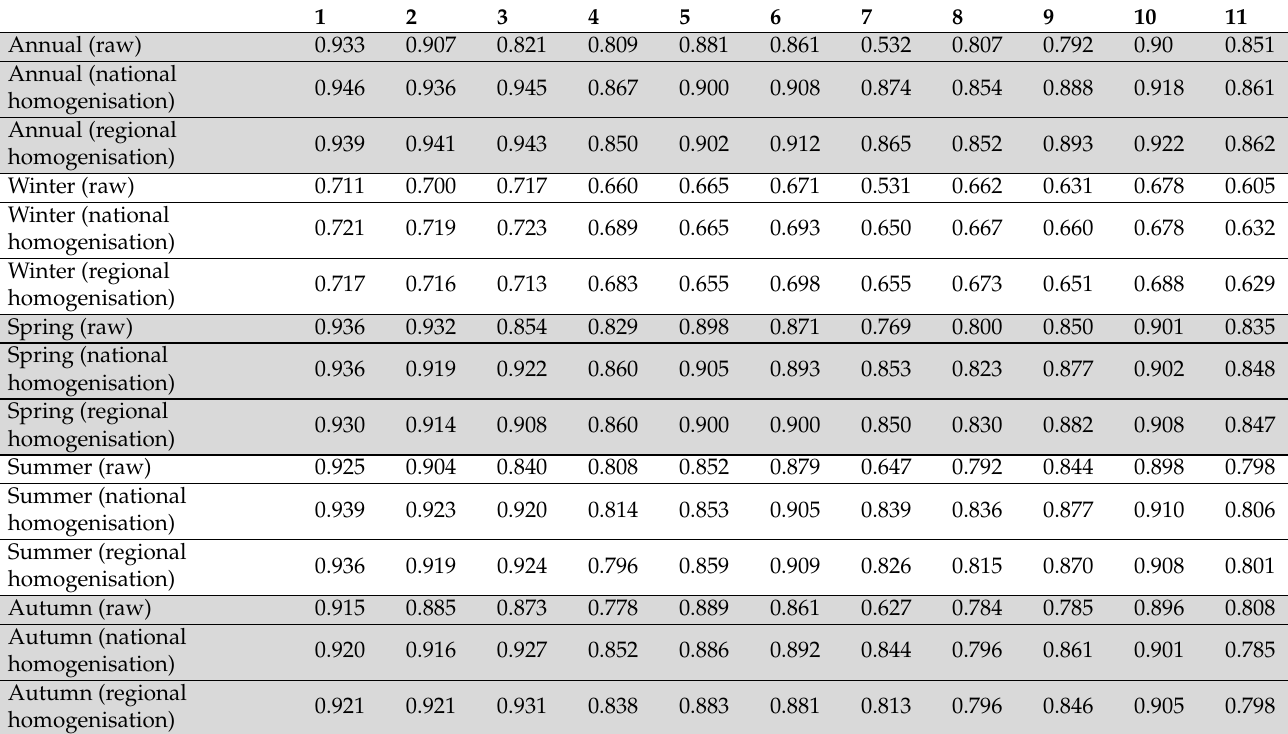
Table A11. Pearson correlations between the Central England series [41] and the raw and homogenised MAX series in 1885–2018. All correlations are significant at the 0.01 level. Series: (1) Phoenix Park Dublin, (2) Botanic Gardens,